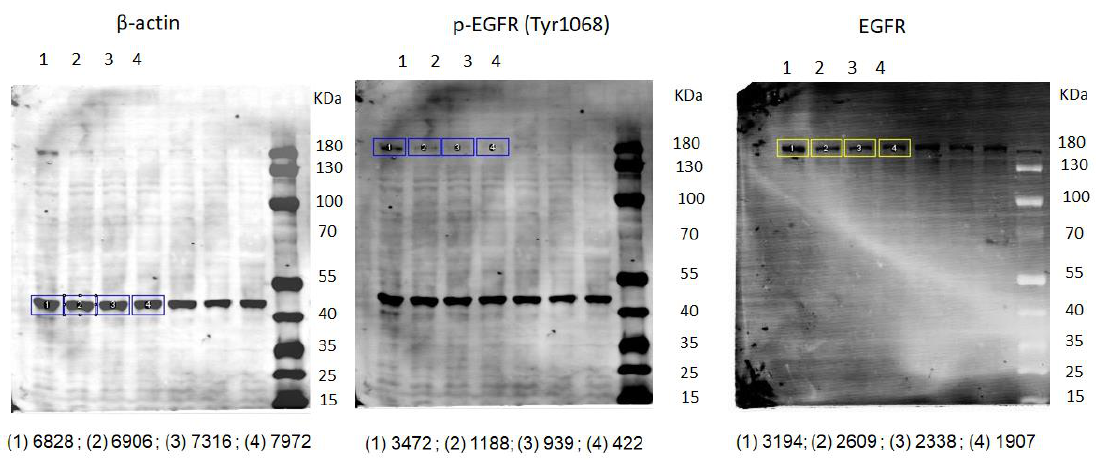
Figure A3. Western blot and densitometry analysis of A431 cells treated with E01-GS-TPD. Western blot pictures from Figure 3a are shown. The densitometry analysis for each sample is shown below each blot (1) untreated 0 µM, (2) E01-GS-TPD 0.1 µM, (3) E01-GS-TPD 0.5 µM, and (4) E01-GS-TPD 1 µM.